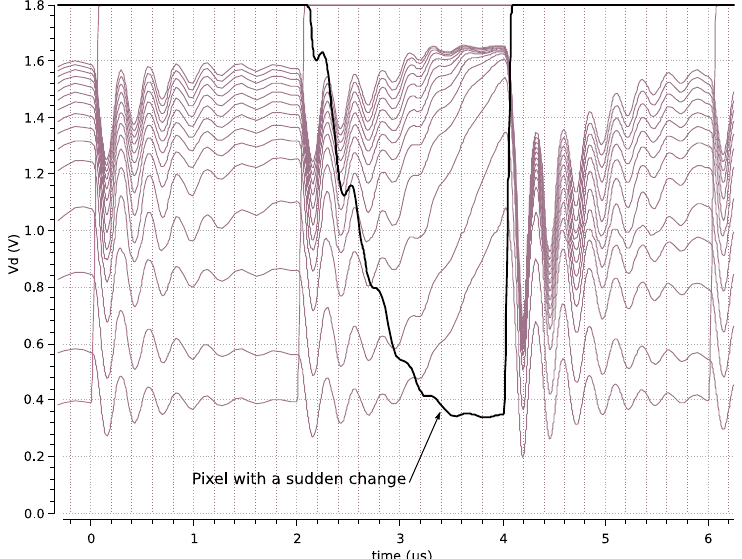
Figure 6. WTA delay when there is a large change in the illumination of one pixel and when it is promoted to be a winner.